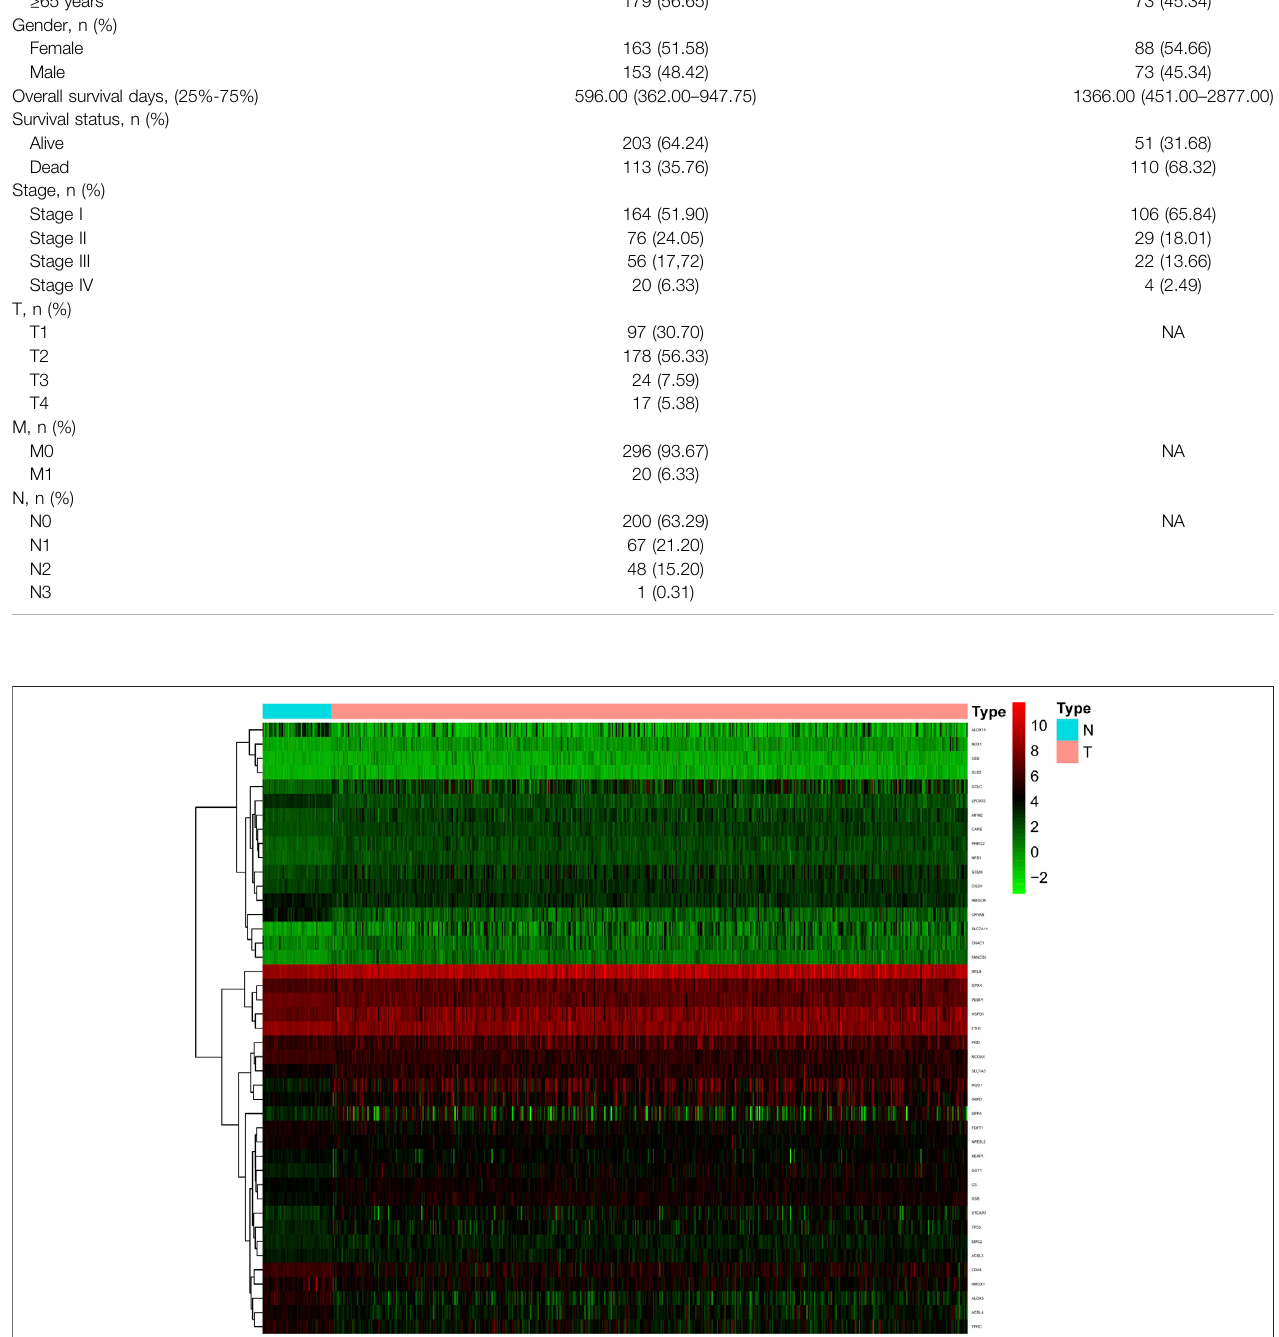
Frontiers in Molecular Biosciences |